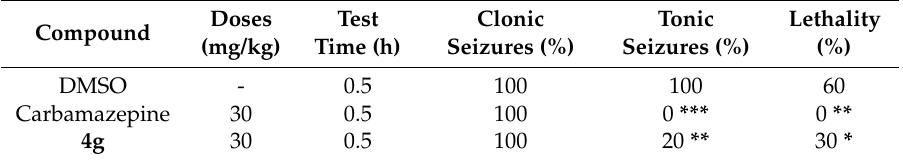
Table 3. Effect of compound 4g on 3-mercaptopropionic-acid-induced seizures in mice.